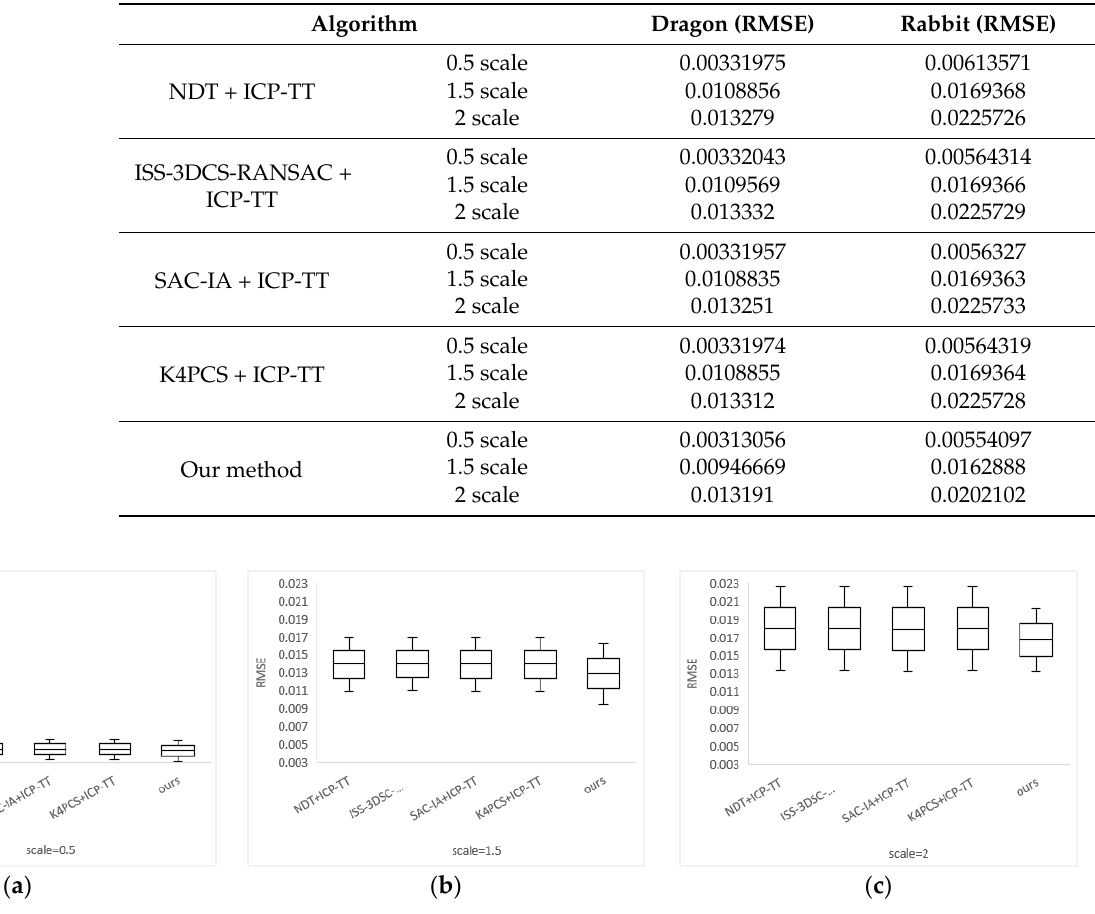
Figure 15. The RMSE boxplot of five coarse-to-fine registration algorithms combined with TT strategy in different scale factors. ( a ) The RMSE boxplot of different coarse-to-fine registration algorithms combined with TT strategy in scale = 0.5. ( b ) The RMSE boxplot of different coarse-to-fine registration algorithms combined with TT strategy in scale = 1.5. ( c ) The RMSE boxplot of different coarse-to-fine registration algorithms combined with TT strategy in scale = 2.